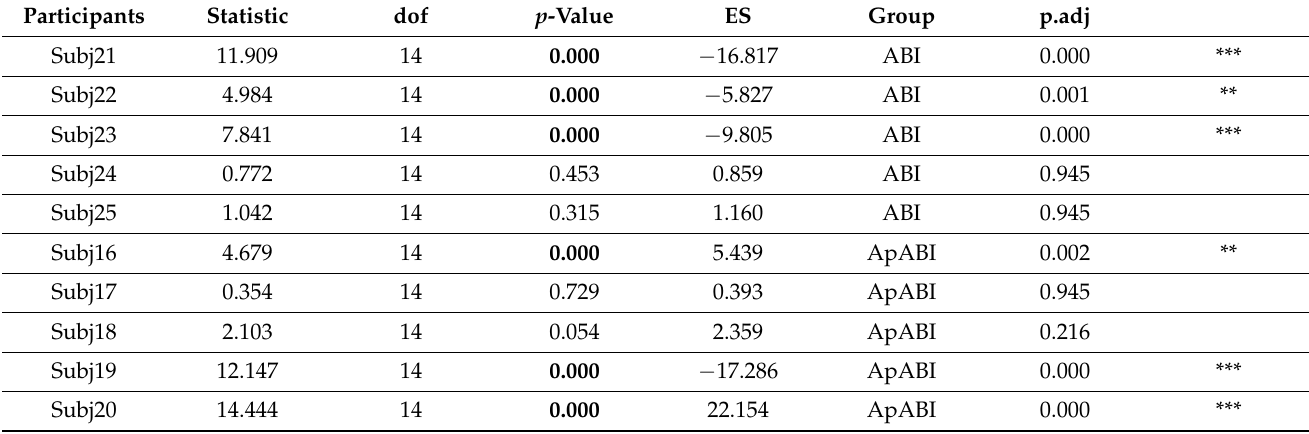
Table 7. Patients’ performance in F-FT.